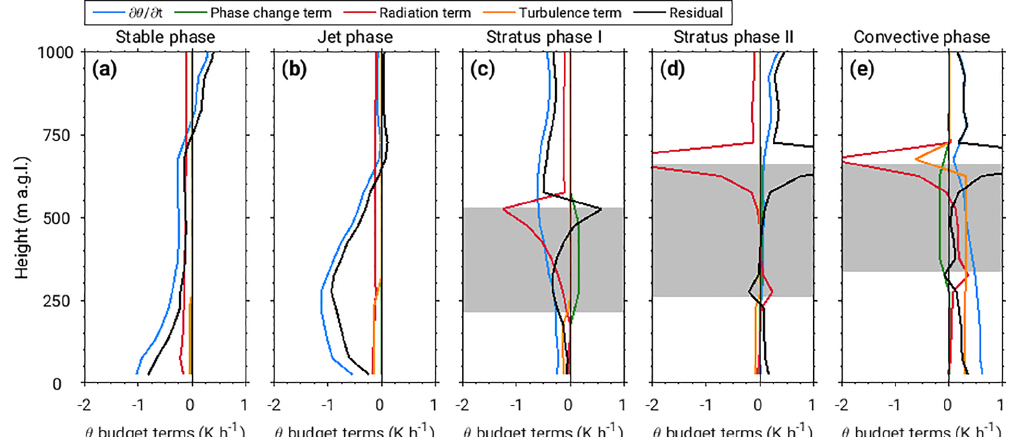
Figure 8. Vertical profiles of heat budget terms: potential temperature tendency (blue), phase change term (green), radiation flux divergence term (red), divergence of the sensible heat flux (orange), and residual term (black) shown for different phases during IOP 8. The shaded gray area indicates the mean cloud